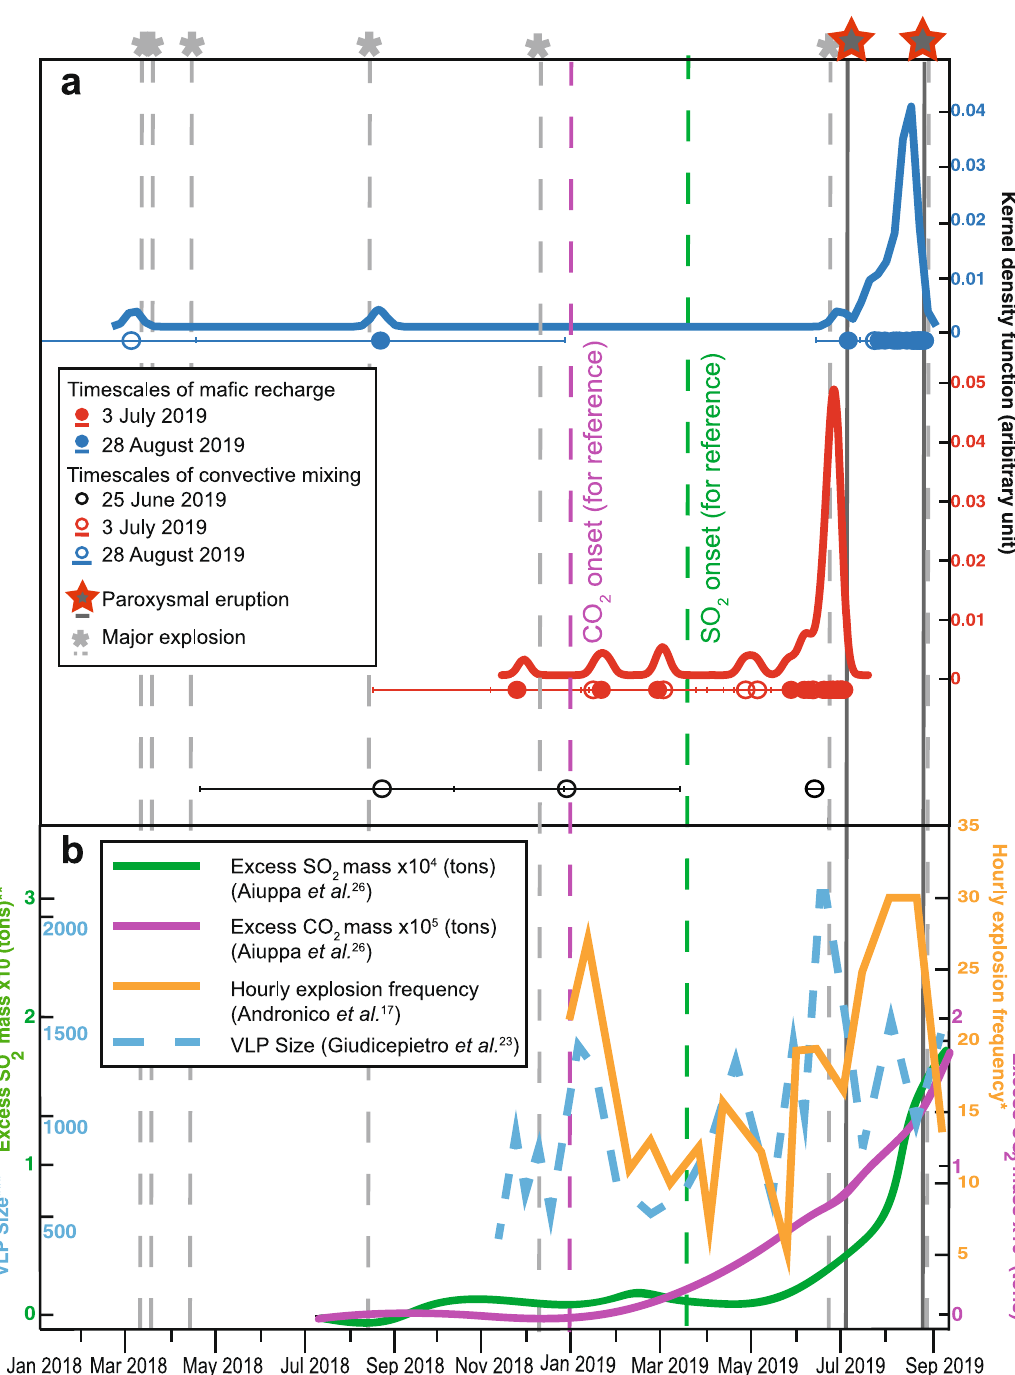
the low density of data. b July 2018 — September 2019 variation of excess of SO 2 and CO 2 fl ux(greenandpurplelinerespectively)ascalculatedbyAiuppaetal. 19 .January — September 2019 variation of hourly explosion frequency (orange line) data from Andronico et al. 10 . November 2018-September 2019 VLP size (amplitude in counts) time series (dashed cyan line) data from Giudicepietro et al. 16 . Dashed vertical light grey lines marked with light grey asterisks: major explosions between January 2018 and September 2019 (data from INGV 46 ); continuous vertical dark grey lines marked with red and grey starts: 3 July and 28 August 2019 paroxysmal